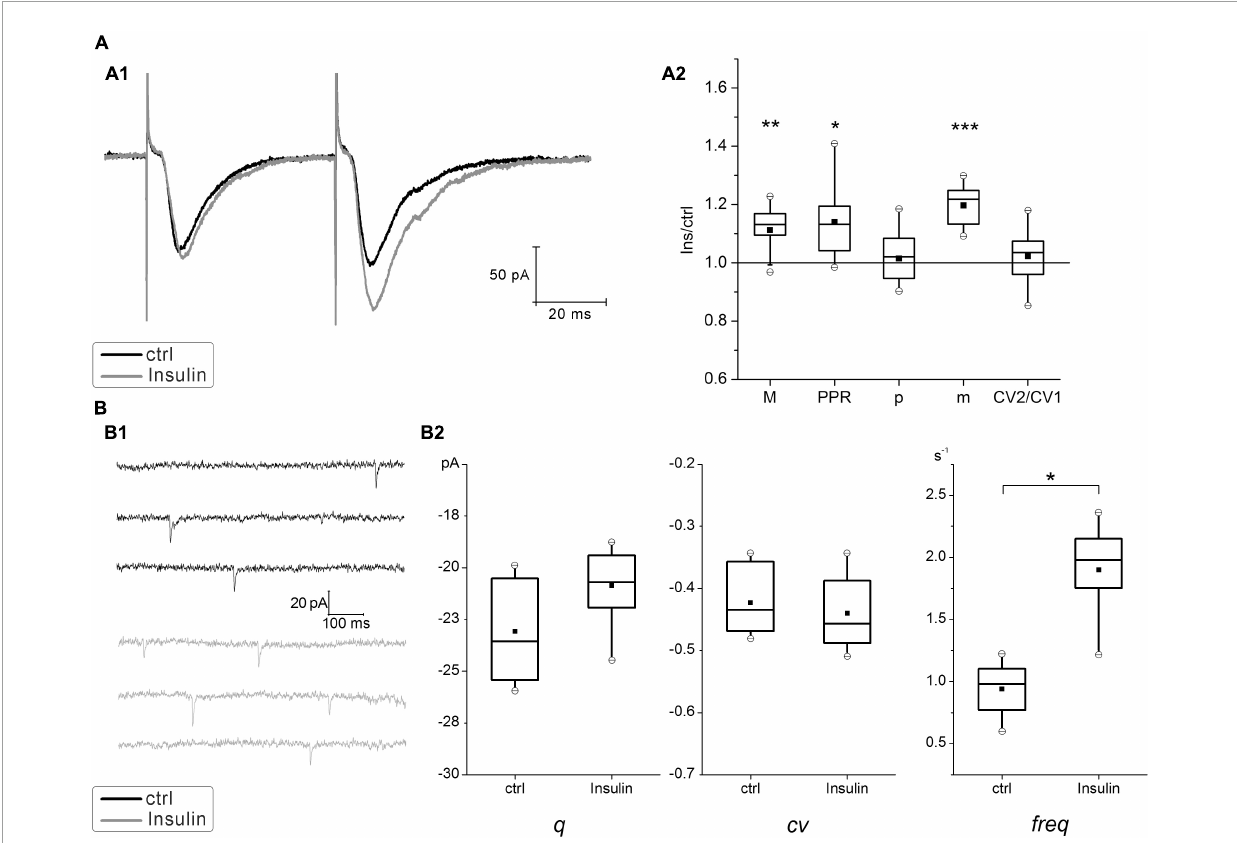
FIGURE2 Effect of insulin on glutamatergic excitatory postsynaptic currents (EPSCs) at hippocampal neurons cultured under normoinsulinemia conditions. (A) Paired-pulse plasticity of evoked glutamatergic excitatory postsynaptic currents (eEPSCs) changes under insulin action. (A1) Sample traces of eEPSCs pairs in control (ctrl) and after 100 nM insulin application (Insulin) in the same single cell (averaged of 30 sweeps). (A2) The box charts show average changes of the 1st eEPSCs amplitudes (M) in the pairs, the coefficient of variation (CV), the paired-pulse ratio (PPR), the release probability ( p ) and the quantal content ( m ) after insulin addition compared with the relative parameters measured at the same synapses in control (taken as 100%). Statistical significance is indicated by: * P < 0.05; ** P < 0.005; *** P < 0.001 compared with control (paired Student’s paired t -test, n = 15). (B) Insulin effects on miniature EPSCs (mEPSCs). (B1) Sample traces of mEPSCs measured at the same neurons before (ctrl) and after (Insulin) extracellular insulin application. (B2) Comparison box charts of mEPSCs amplitude (quantal size, q ), the coefficient of variation of mEPSCs (cv) and mEPSCs frequency (freq) before (ctrl) and after (Insulin) insulin addition. Statistical significance is indicated by: * P < 0.05 compared with control (Student’s paired t -test, n =